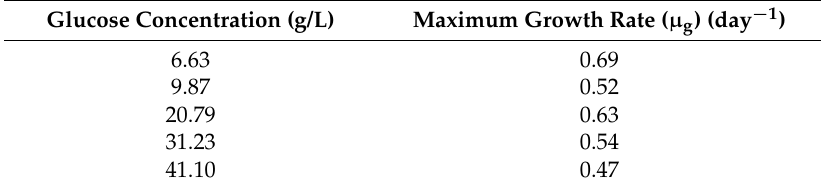
Figure 4. Growth rates of A. woodii at different concentrations of glucose for determination of the maximum growth rate and growth rate constants (K s and K i ) using Monod kinetics. Table 2. Maximum growth rate constants for different glucose concentrations calculated using Equation